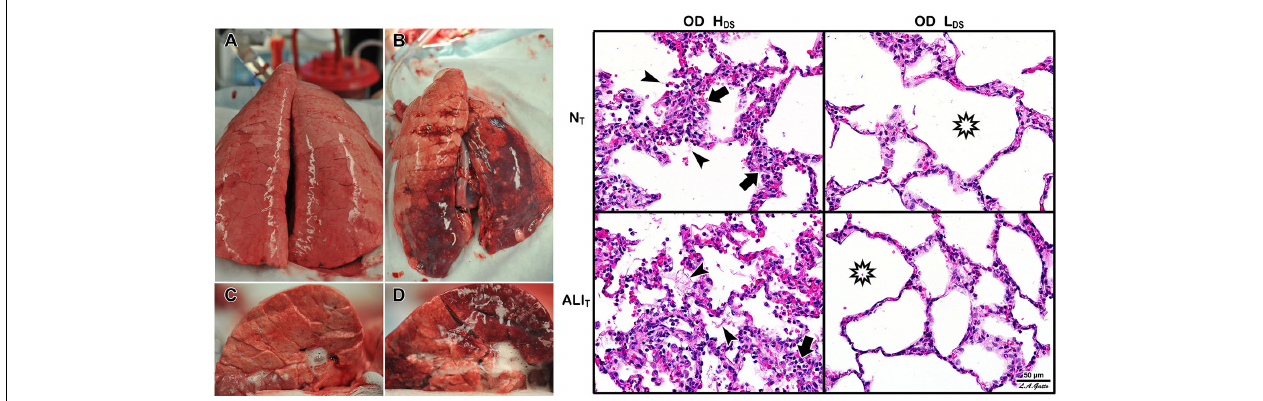
FIGURE 5 | Heterogeneous Tween Injury in pigs ventilated for 6 h. A bronchoscope was used to deliver Tween to the dependent areas of the diaphragmatic or caudal lung lobes. Thus, the upper lobes would be normal homogeneously inflated tissue (i.e., would simulate the baby lung), and the dependent areas of the caudal lobe would model acutely injured tissue that would be either collapsed or unstable during tidal ventilation. Using this injury model we can determine whether a ventilation strategy protects either normal tissue (N T ) or acutely injured lung tissue (ALI T ), protects neither, or protects both. Two groups were studied. Both groups were subjected to a high static strain (Pplat = 40 cm H 2 O) hypothesized to be sufficient to cause overdistension (OD)-induced VILI to the baby lung (Acute Respiratory Distress Syndrome Network, 2000). One group was also subject to high dynamic strain (H DS ) and the other to low dynamic strain (L DS ). The dynamic strain was adjusted using the airway pressure release ventilation (APRV) mode by changing the expiratory duration, which changed tidal volume size. Left – Gross photographs of the whole lung (A,B) and cut surface (C,D) of the diaphragmatic lung lobe. The L DS group (A,C) showed minimal damage in both N T and ALI T lung tissue (i.e., no dark red hepatized atelectasis). This was in contrast to the H DS group, in which there was severe injury in both the N T and ALI T lung tissues (B,D) . Right – In the OD + H DS group (OD + H DS ), widespread histopathology typical of ARDS was seen, with inflammatory cell inflation (arrows) and fibrin deposits (arrowheads) in both the N T and ALI T lung tissue. In the OD + L DS group, minimal histopathology was seen, and alveoli remained open (stars) in both N T and ALI T lung tissue. These data support Protti et al.’s (2013b) work and demonstrate that normal lung tissue is highly resistant to static strain-induced volutrauma. In addition, this study showed that acutely injured lung tissue is also resistant to volutrauma as long as dynamic strain remains low. Both normal and acutely injured lung tissue are highly susceptible to high alveolar R/D-induced VILI when under high inflation pressure (Jain et al., 2017). These data support the rapid progression of lung injury in a power-law fashion when high static and dynamic strain are combined (Hamlington et al., 2018).